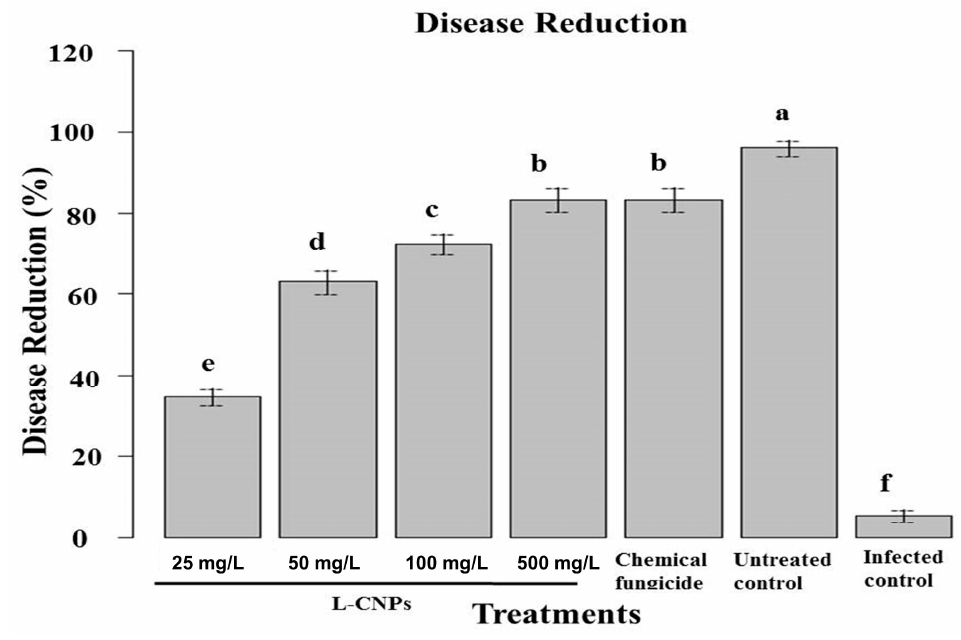
Figure 4. Effect of seed treatments with L-CNPs at different concentrations on disease reduction in maize inoculated with F. verticillioides (21 days after inoculation) in pot experiments. Data are expressed as mean ± standard deviation (SD) of three replicates. Mean values with different letters are significantly different according to the least significant difference (LSD) test at p < 0.05.